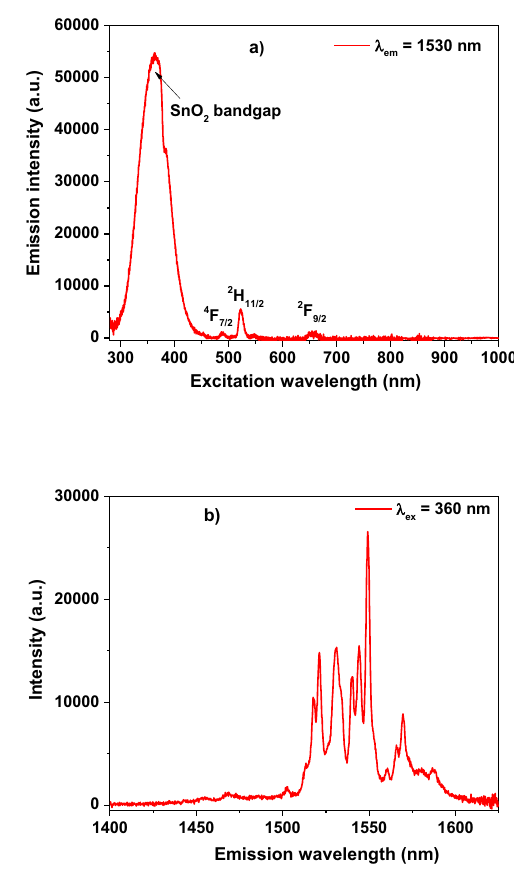
Fig. 3. a) Excitation spectrum monitored at emission λ em =1530 nm of Er 3+ and b) emission spectrum under excitation at UV SnO 2 bandgap (λ ex = 360 nm) using Edinburgh FLS980 spectrofluorometer of the SiO 2 - SnO 2 :Er 3+ glass-ceramic monolith containing 10 mol% SnO 2 and activated by 0.5 mol% Er